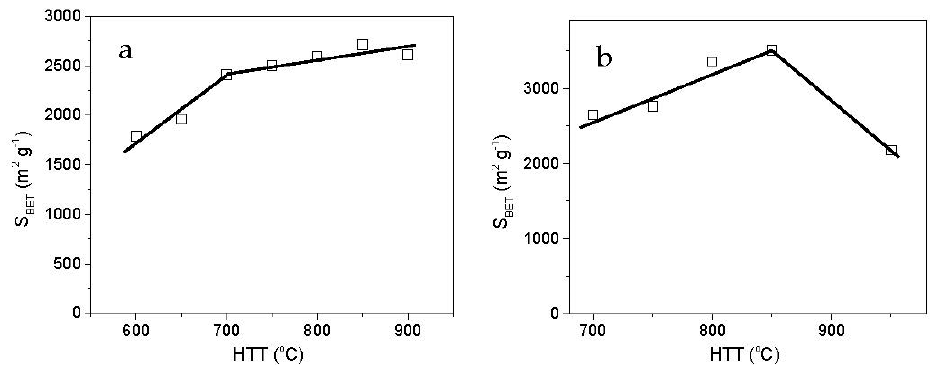
Figure 7. Effect of reaction temperature on the BET surface area of coal-tar mesophase ( a ) and of / KOH ratio of 1:3 for 1 h ( a ) and 2 h ( b anthracite ( b ) activated with KOH at a precursor/KOH ratio of 1:3 for 1 h ( a ) and 2 h ( b ). anthracite ( b ) activated with KOH at a precursor